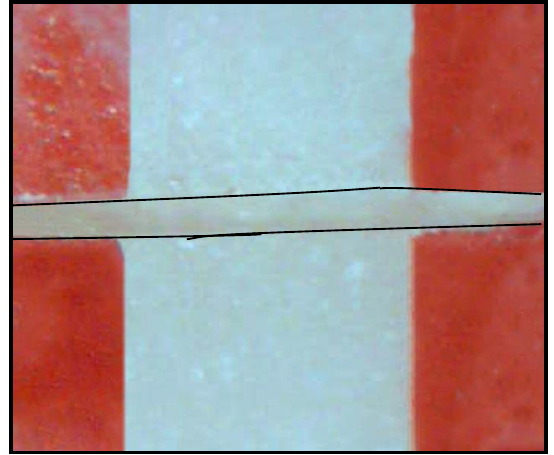
Figure 5: Digital image captured by digital